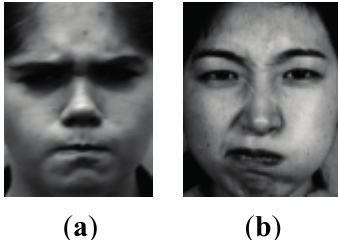
Figure 12. The same expression from different datasets. ( a ) The CK+ dataset; ( b ) The JAFFE